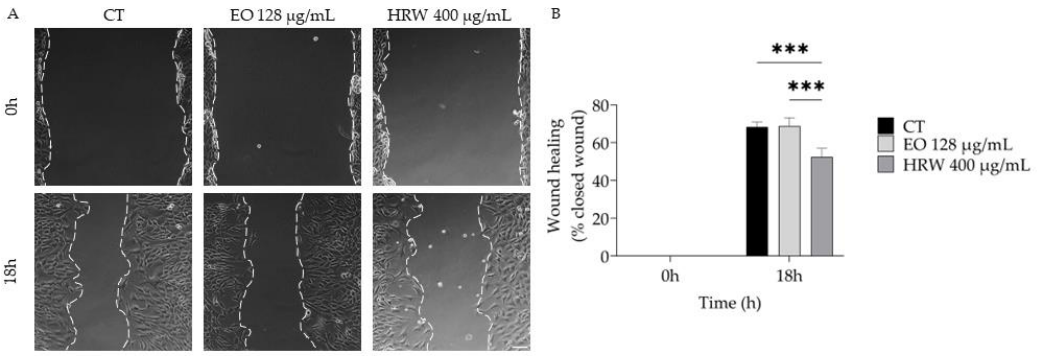
Figure 6. Effect of T. capitata EO and HRW on NIH/3T3 fibroblast migration. Representative bright-field images ( A ) and quantification of closed wound using the wound healing size plugin for ImageJ/FIJI ( B ). *** p < 0.001 when compared to control (CT) after a two-way ANOVA followed by Sidak’s multiple comparison test.